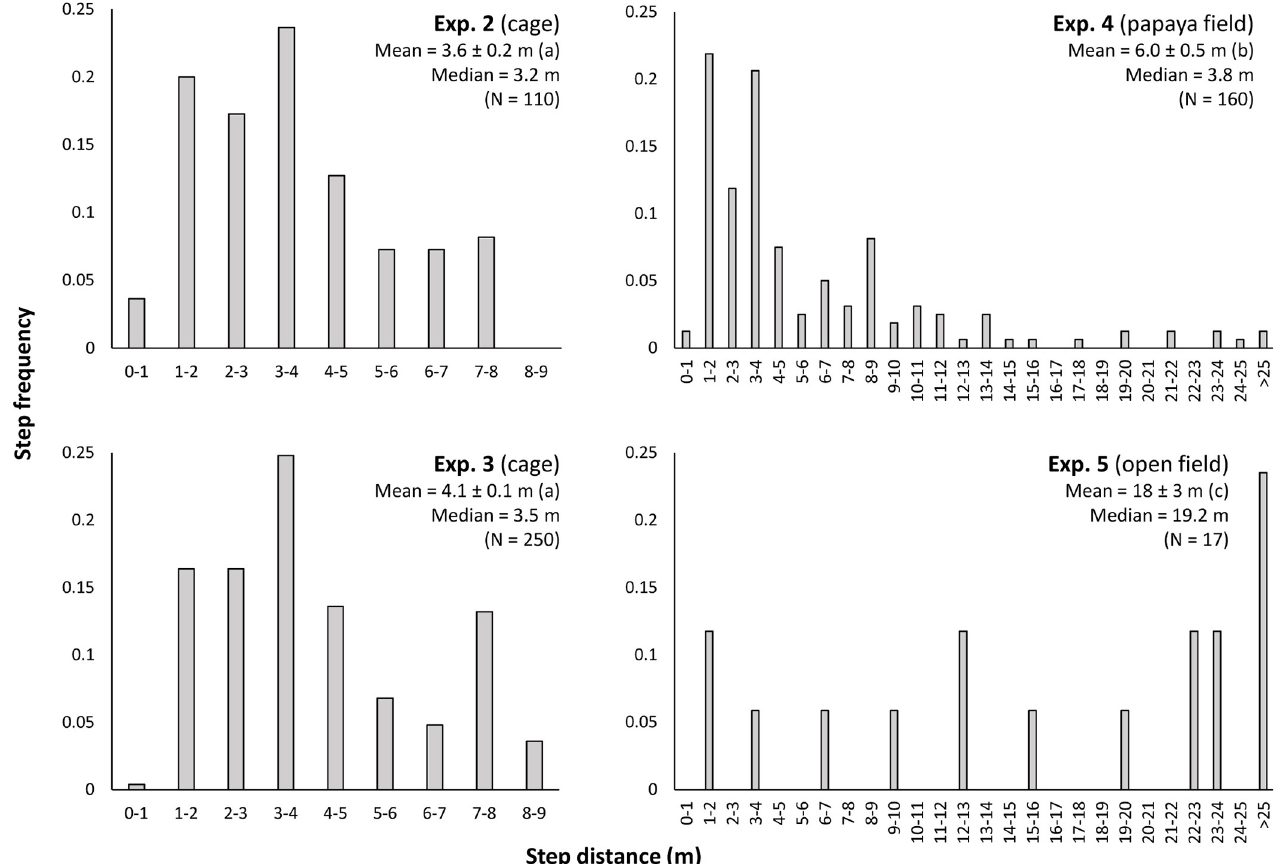
Fig 4. Melon fly, Zeugodacus cucurbitae , flight step-distances for experiment 2–5. Different letters, in parentheses, indicate significant differences by ANOVA followed by means separations with Student-Newman-Keuls ( P = 0.05).